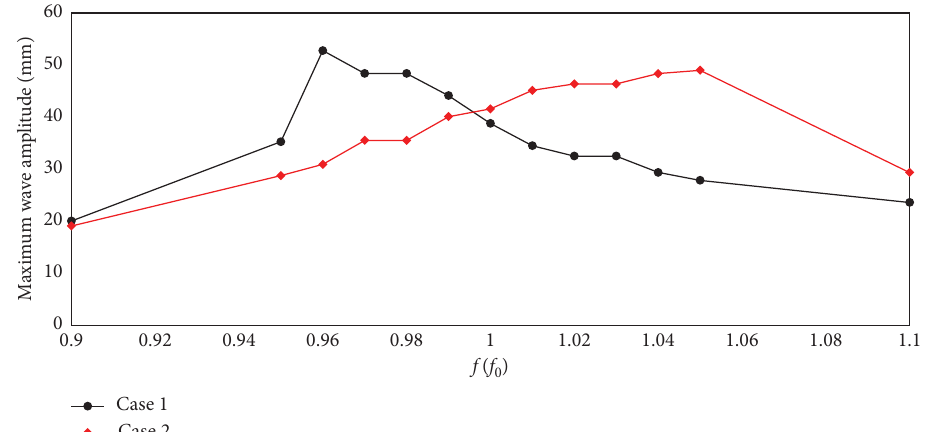
Figure 5: Maximum wave amplitude comparisons of the tank with vertical baffle and the tank with T-type baffle under pitch